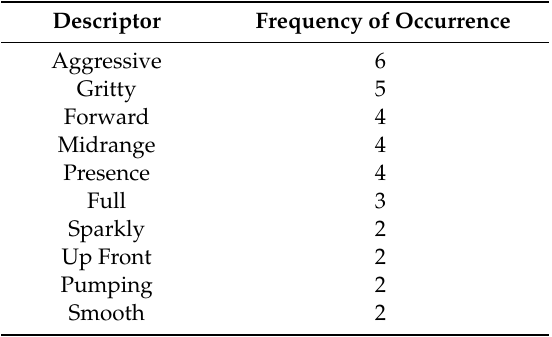
Table 2. Descriptors used for 1176 vocal